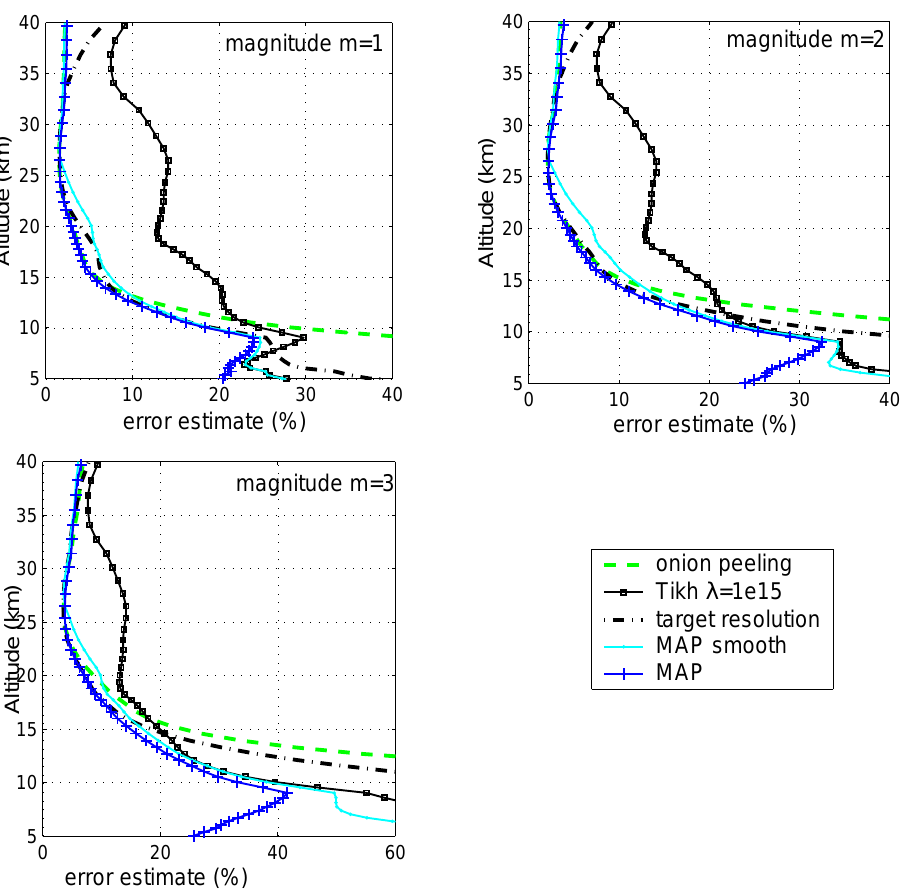
Fig. 7. Total error of ozone profile retrieval in the lower atmosphere, for stars of various magnitudes and of the effective temperature T = 10000K.